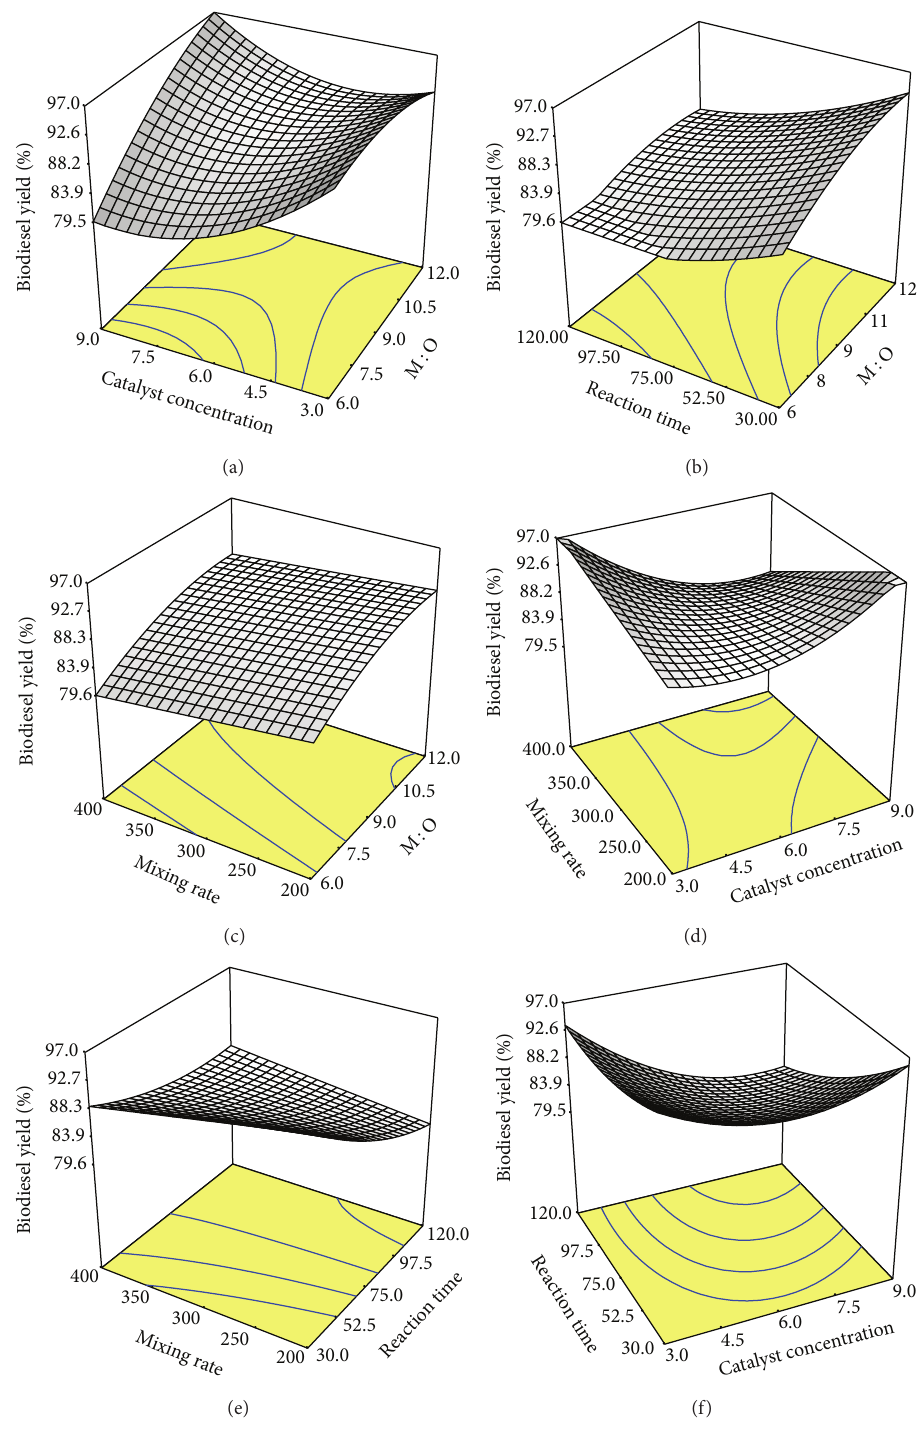
Figure 11: Response surface plots of biodiesel yield using CaO prepared from waste crabs